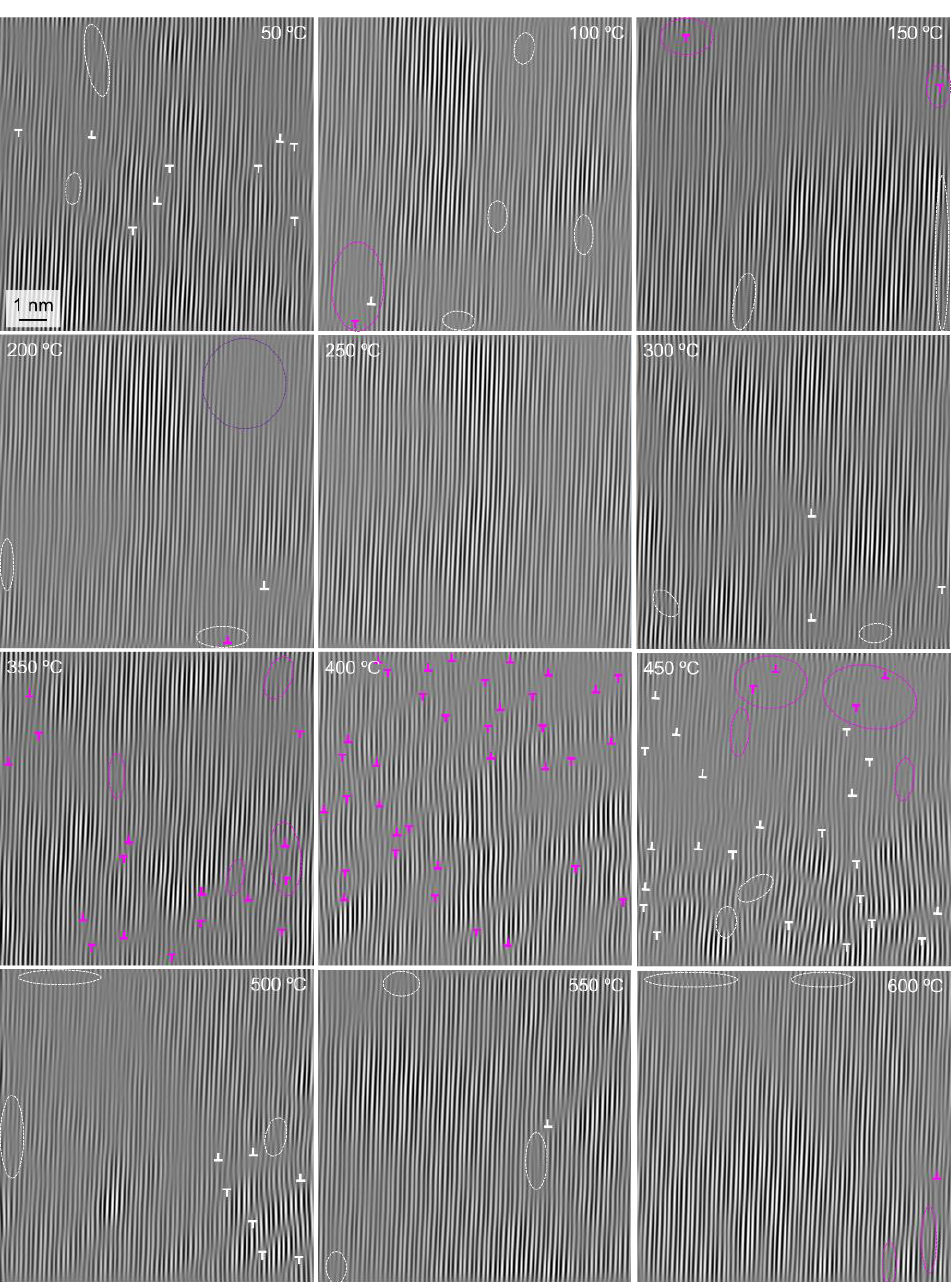
Figure 8. Changes in the number of dislocations in the γ phase near the two -phase interface during heating.